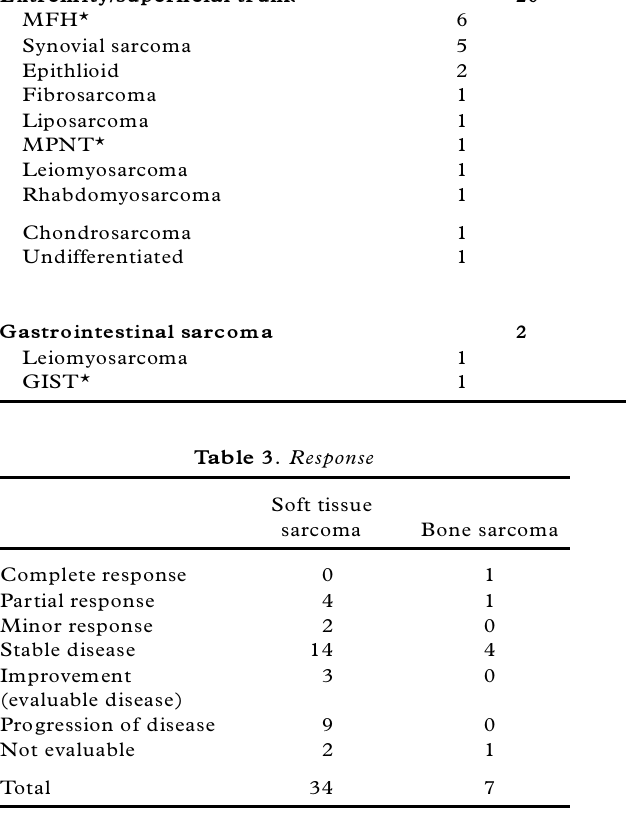
Table 2. Primary sites of soft tissue sarcoma in 34 patients treated with ifosfamide + G-CSF +/± edatrexate Extremity/super® cial trunk